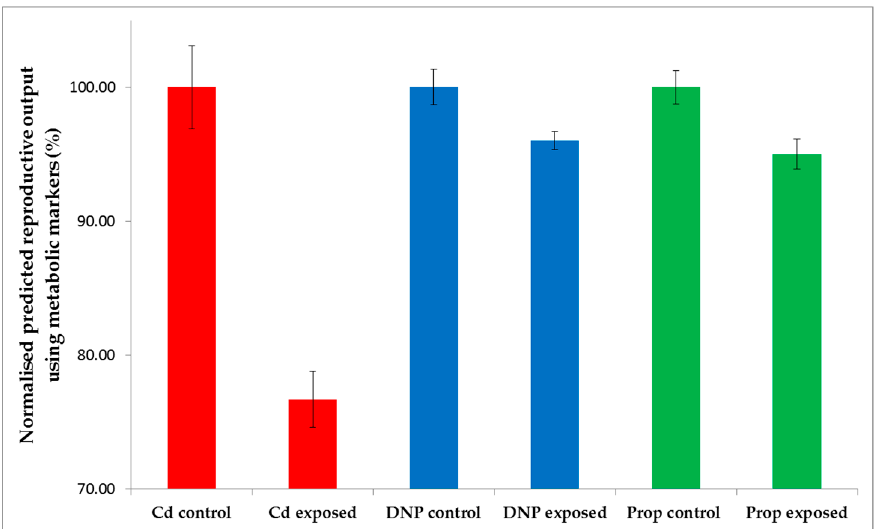
Figure 5. Predictions of the reproductive outputs for individual D. magna following hypothetical 21-day exposures to Cd, DNP and propranolol, relative to untreated controls, derived by submitting three previously published acute toxicity metabolomics datasets [29] to the non-chemical-specific forward selected PLS-R model from this study. Reproductive outputs are normalized for each chemical, with the control group set at 100%. Error bars represent ±SEM.